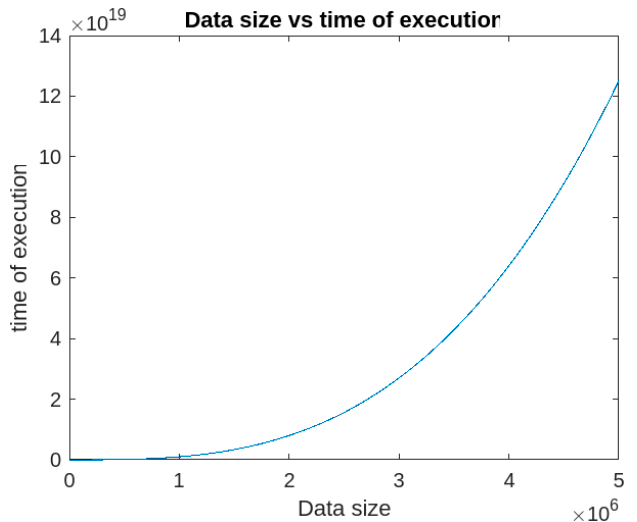
Figure 8. Data sizes vs. time of execution.